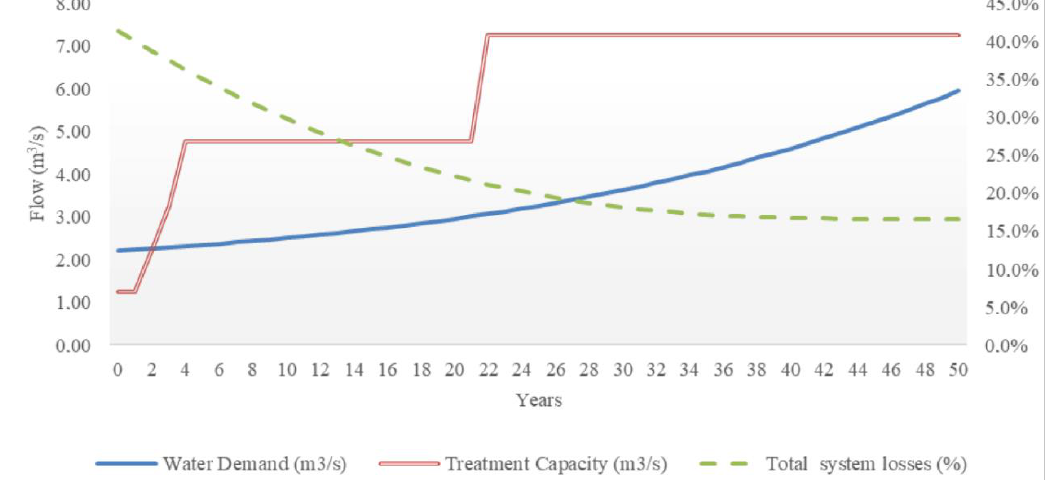
Figure 12. Alternative 7: water demand, treatment capacity and system losses.